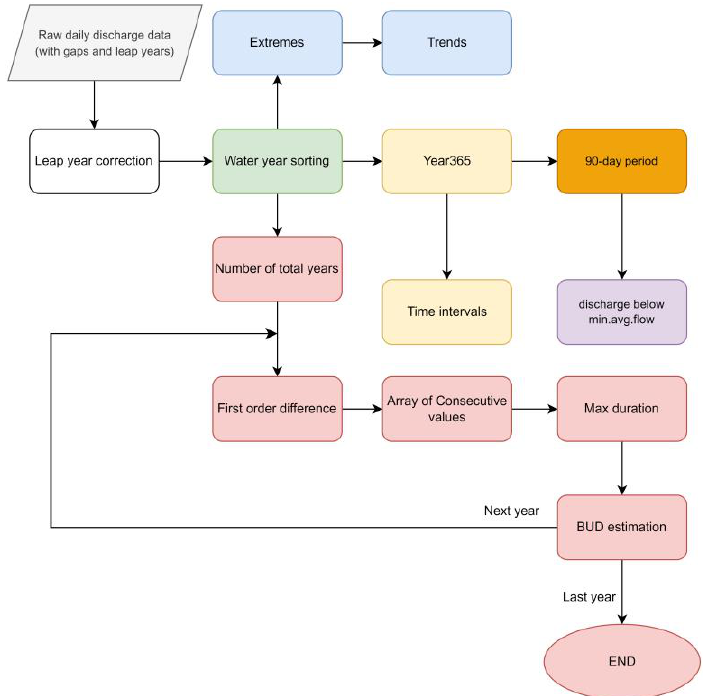
Figure 2. ( a ) Break-up detection in Polmak, Tana River; ( b ) break-up detection in Kukkolankoski, Tornio River. The break-up detection results are available in Supplementary Materials Figure S1 and S2 folders.